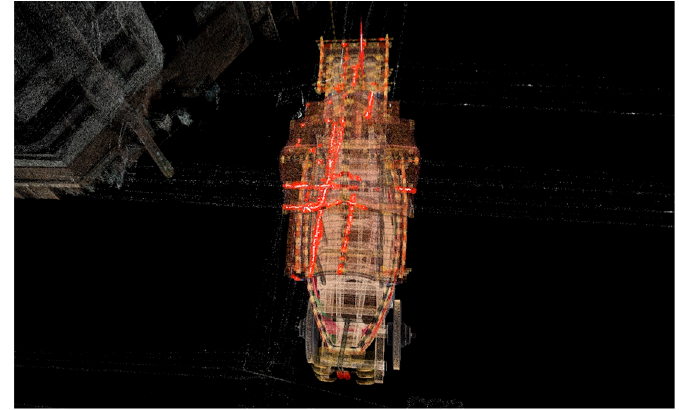
Figure 15. Highlighted collision areas (white) together with the surrounding narrow areas with very high collision risk (red).